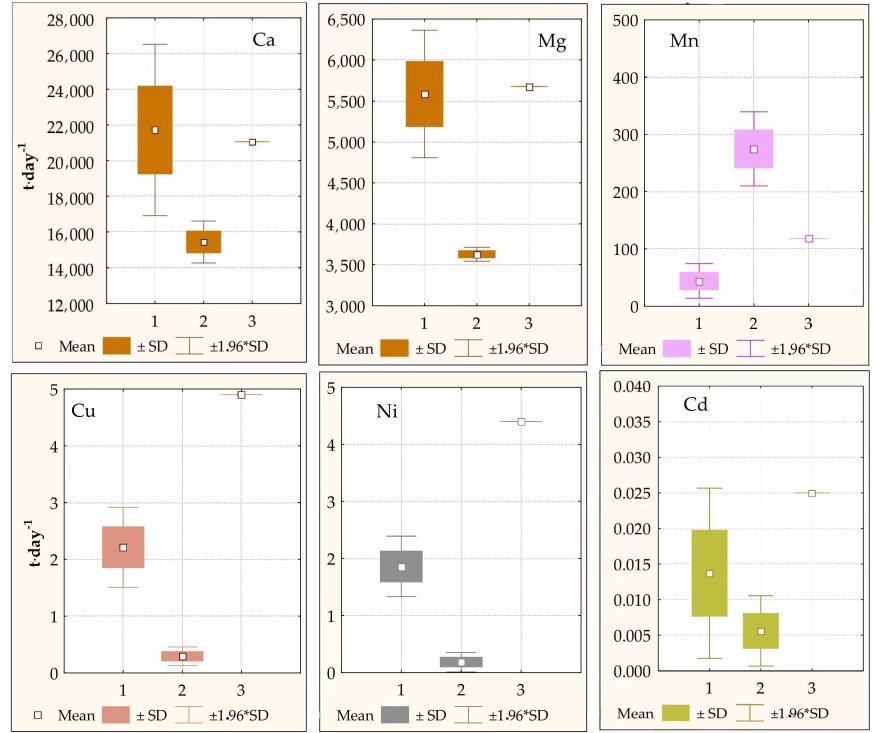
Figure 3. Total flux (t · day − 1 ), mean value of Ca, Mg and trace elements with Ob waters: 1—summer– fall low-water period 2020 (our data); 2—ice period 2021 (our data); 3—average for Ob River (data from [22] was